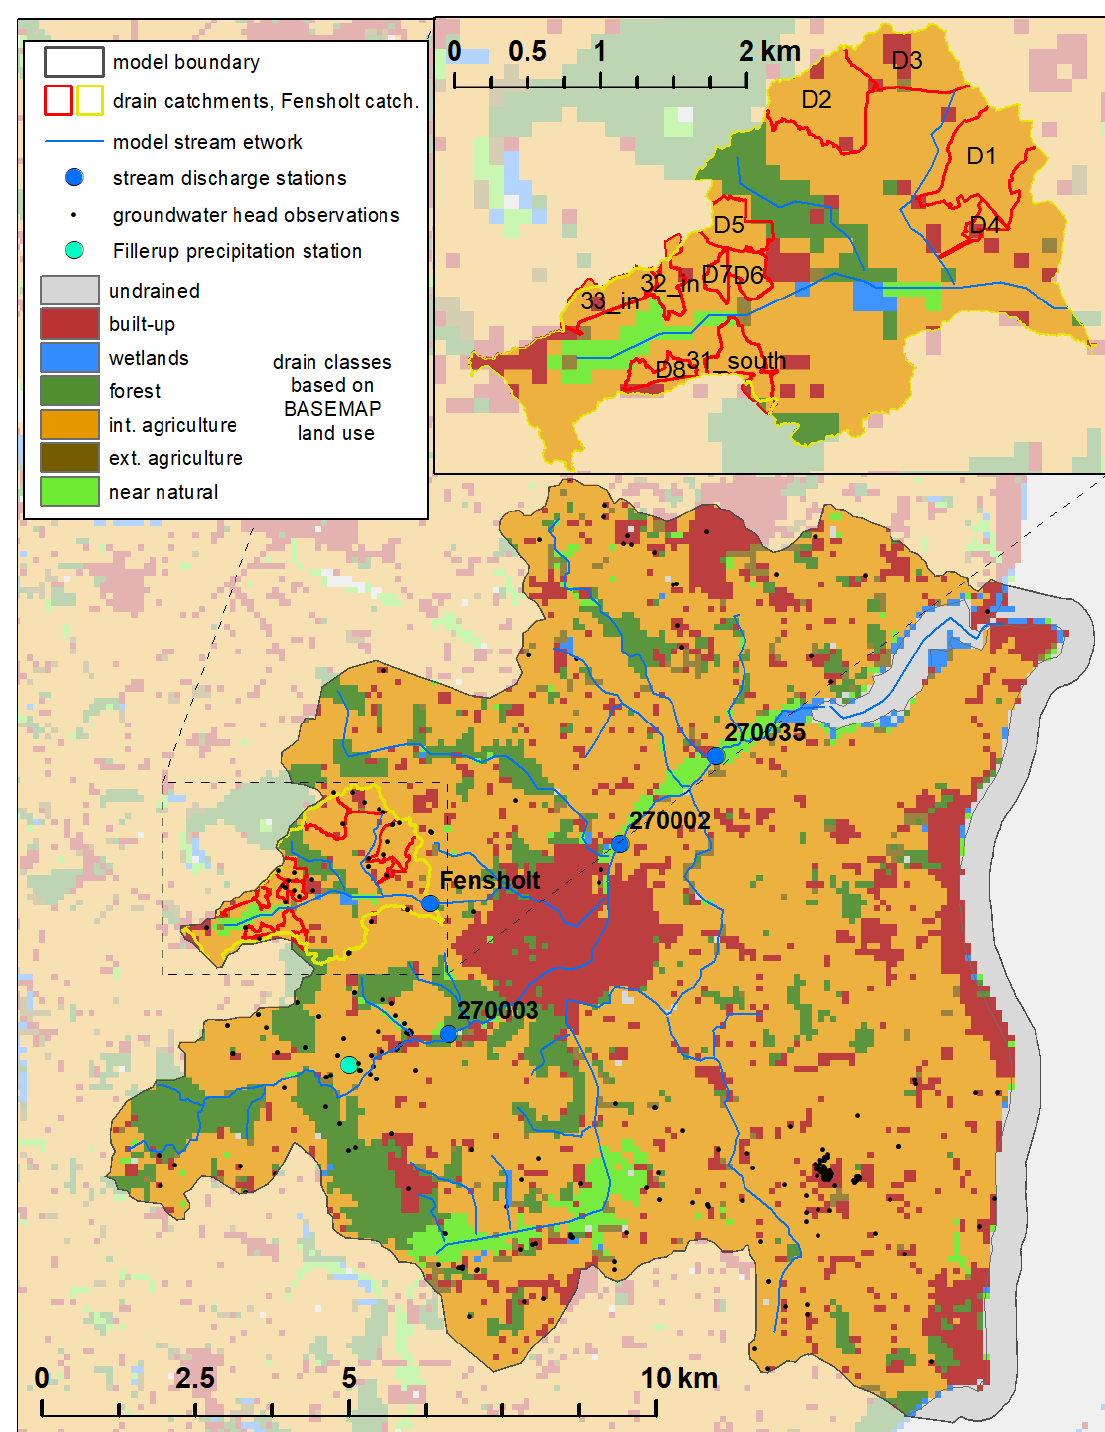
Figure 3. The Norsminde Fjord model area. The inset map on top shows the Fensholt sub-catchment; the drain catchments within it are labelled. The groundwater head data as well as discharge stations used in the calibration are displayed in the main map. The background displays the drain classes as presented in Table 2.